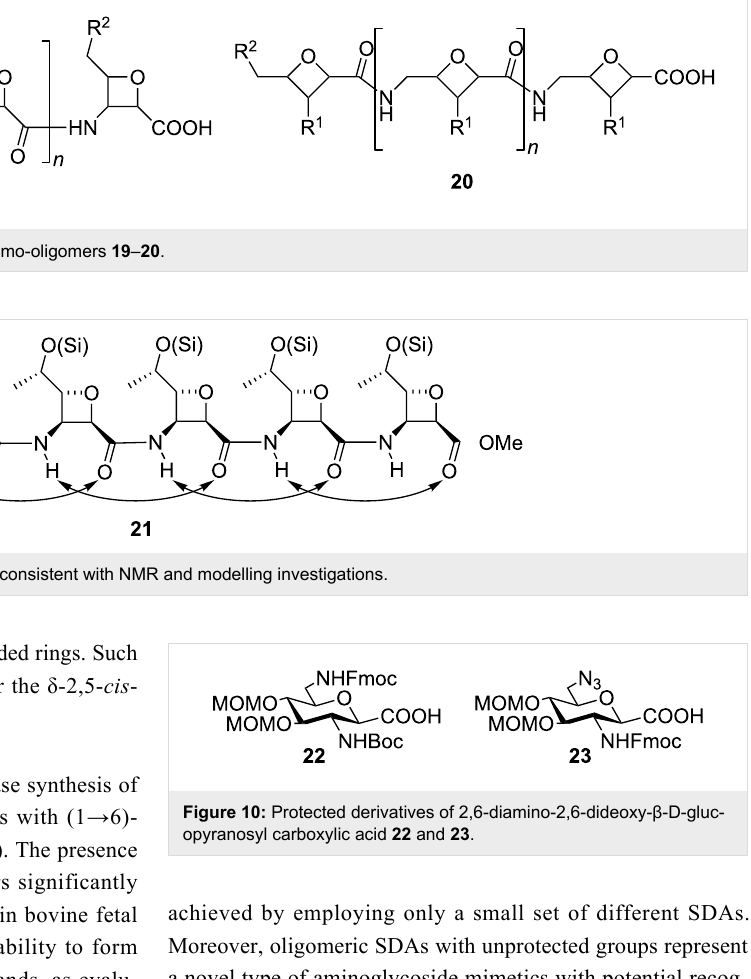
achieved by employing only a small set of different